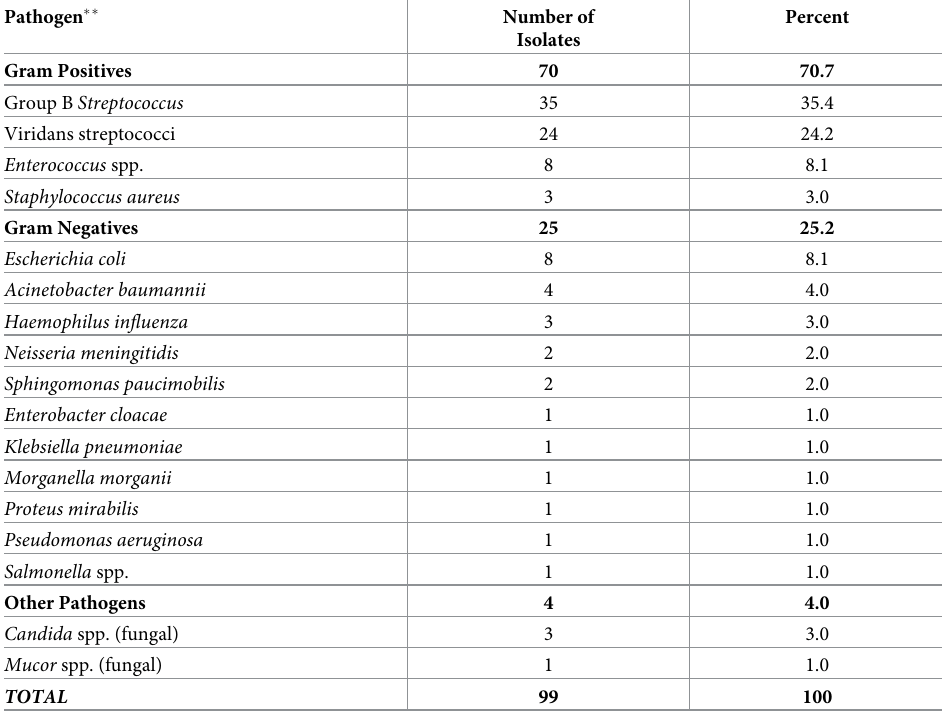
Table 2. Blood culture isolates by pathogen among neonates with protocol defined early-onset sepsis � (n = 1,231)— SANISA Study, Soweto, South